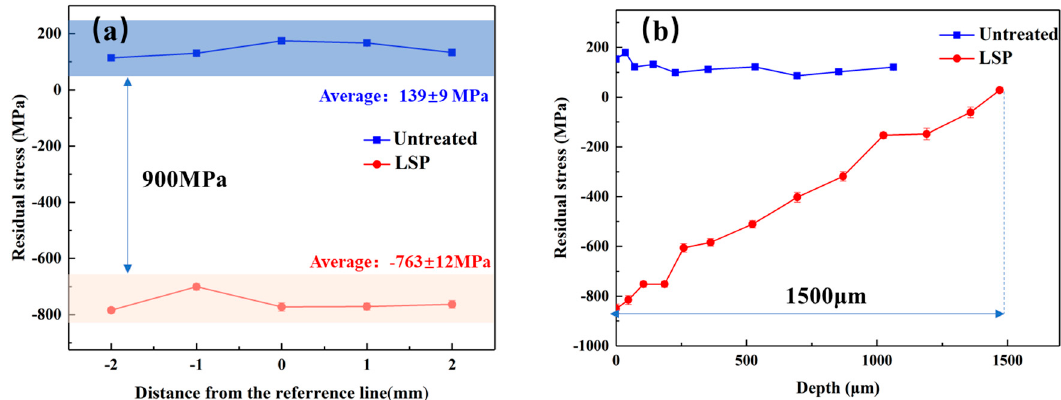
Figure 3. Residual stress distribution of specimens with and without LSP. ( a ) Surface; ( b ) depth.